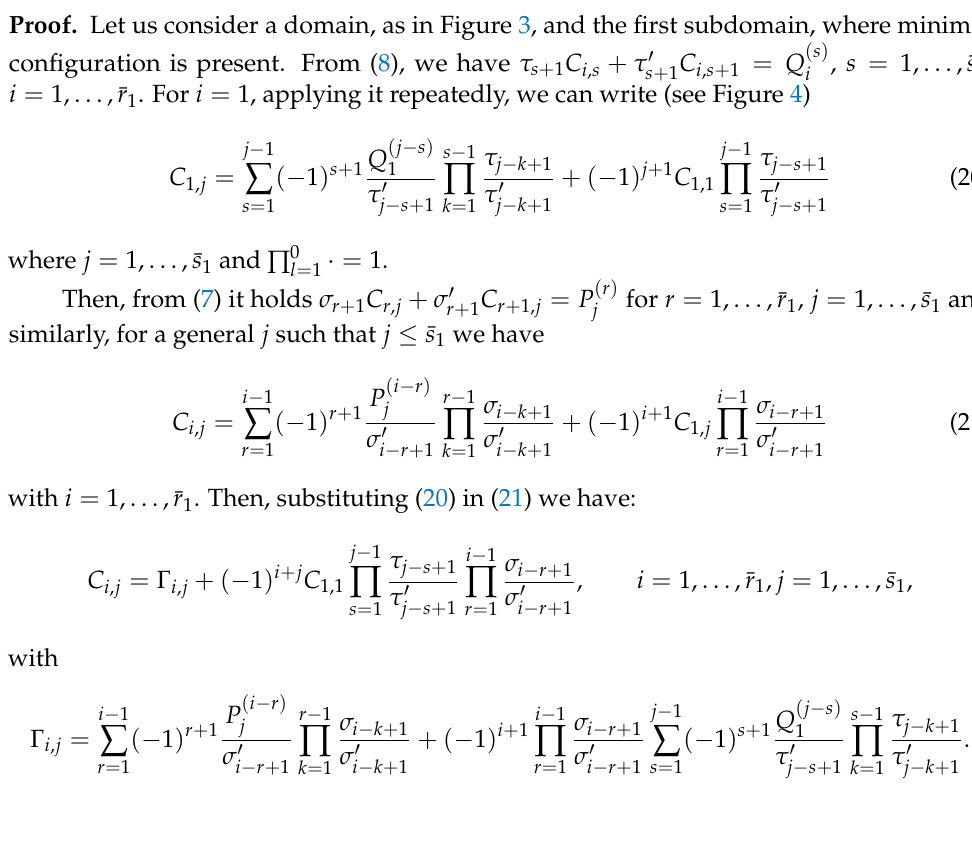
Figure 3. Example of domain for Lemma